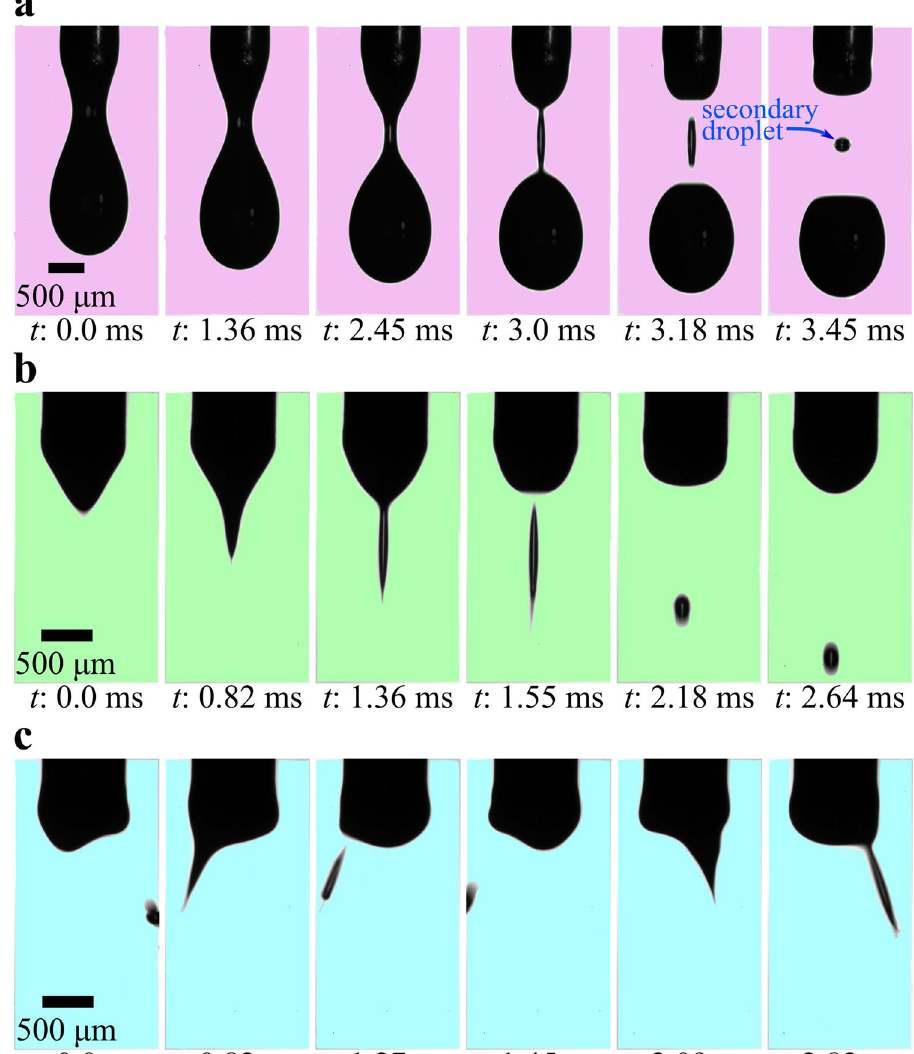
Figure 1. Droplet formation from the capillary tube under the action of an electric field. ( a ) Dripping mode of Si, 5 wt% in H 2 O (H 1 = 4 mm, φ o = 2500 V). The main droplet is formed along with a secondary droplet. ( b ) Microdripping mode of Si, 5 wt% in H 2 O (H 1 = 4 mm, φ o = 4000 V). Uniform monodisperse drops are generated from the conical meniscus. ( c ) Oscillating microdripping mode of Si, 5 wt% in H 2 O (H 1 = 4 mm, φ = 5000 V). The conical meniscus oscillates in a plane ejecting drops in two o